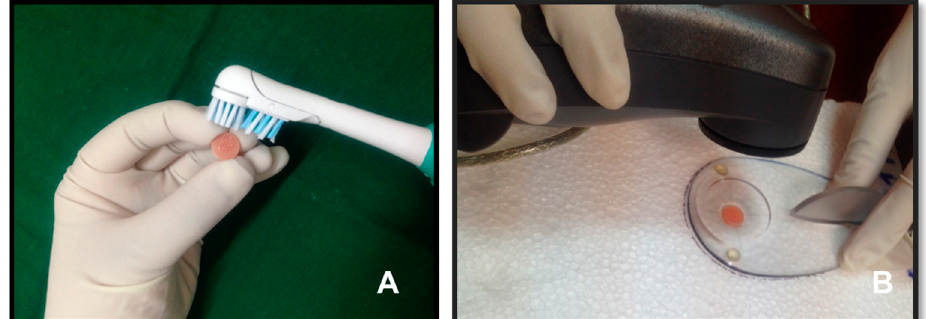
Figure 5. ( A ) Specimen cleaned using electric toothbrush and toothpaste. ( B ) Spectrophotometer used to measure the color change of specimen after 2 weeks of immersion in staining